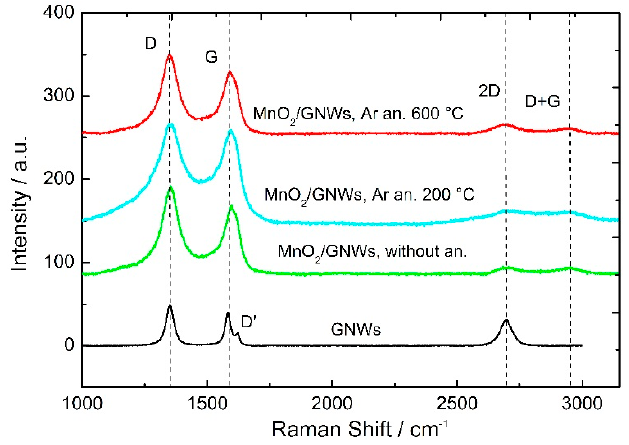
Figure 3. Raman spectra of GNWs grown on SS and MnO 2 /GNWs samples without annealing and Argon annealing at 200 and 600 °C.